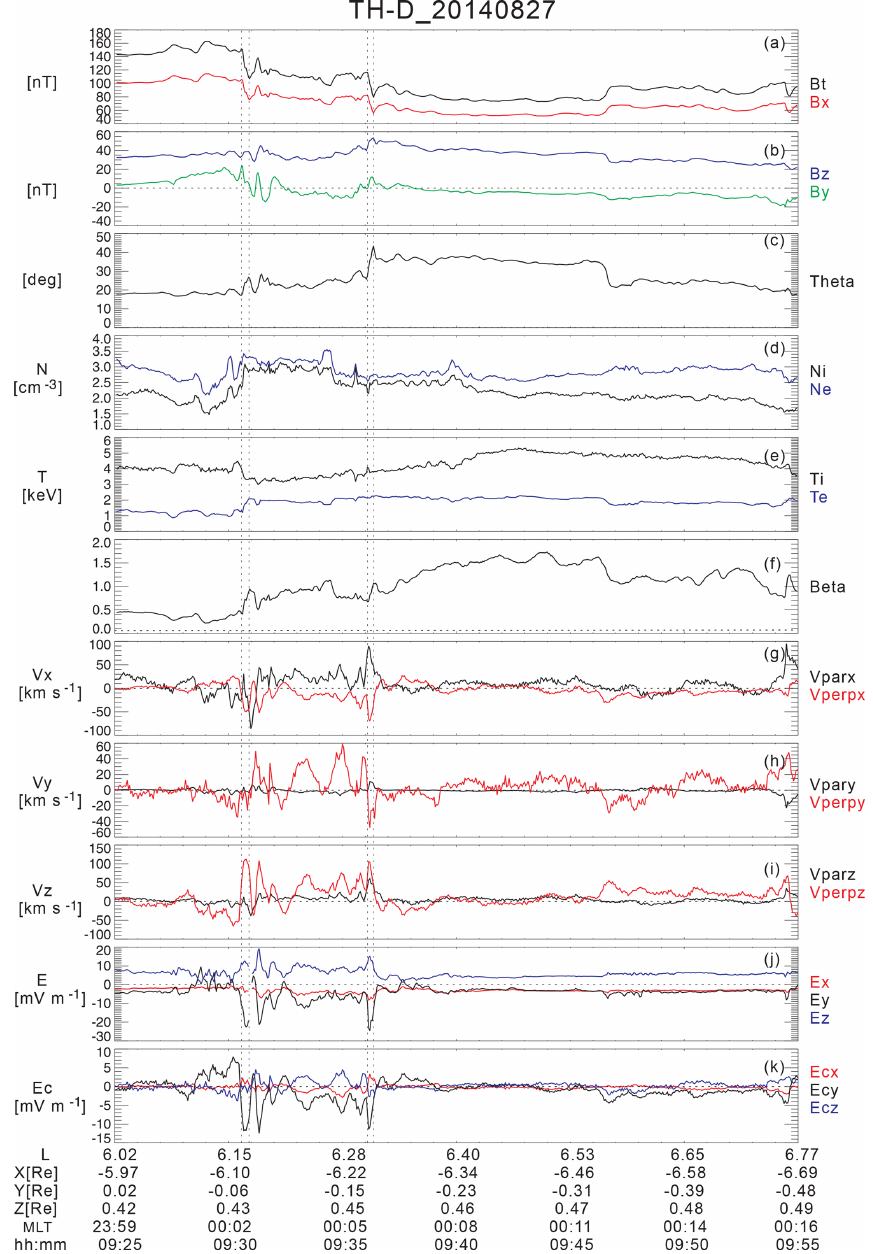
Figure 3. The electromagnetic field and plasma parameters detected by TH-D in intervals from 09:25 to 09:55UT on 27 August 2014. The solar magnetic (SM) coordinate system is adopted. From top to bottom, panels show (a) the total magnetic field B t (black) and the X component B x (red), (b) the Y component B y (green) and the Z component B z (blue), (c) the magnetic field elevation angle θ ; (d) ion and electron density N i , N e , (e) ion and electron temperature T i , T e , (f) plasma beta β , (g) the X component of ion parallel velocity and perpendicular velocity V parx , V perpx , (h) the Y component of ion parallel velocity and perpendicular velocity V pary , V perpy ; (i) the Z component of ion parallel velocity and perpendicular velocity V parz , V perpz , (j) the electric field E x (red), E y (black) and E z (blue) by assuming E × B = 0 and (k) the electric field E cx (red), E cy (black), E cz (blue) calculated by E = B × V . The black vertical dashed lines mark the times 09:30:34, 09:30:54, 09:36:06 and 09:36:21UT,